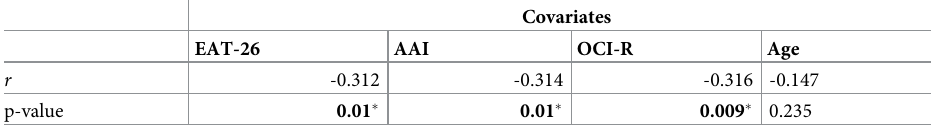
and the covariates across HC and ED groups. MB